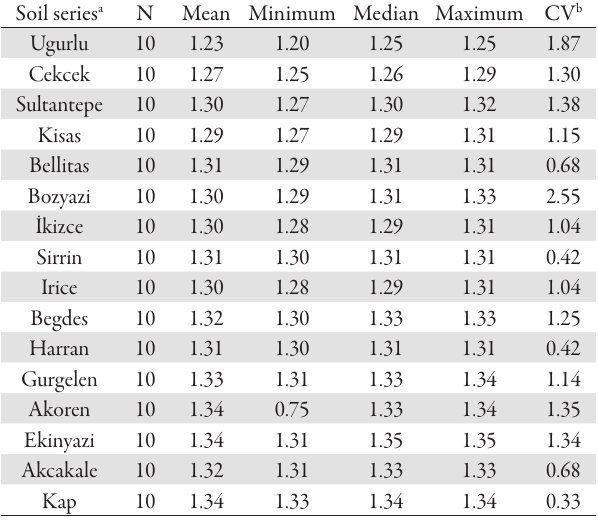
Tab. 3. Statistical distribution of bulk density (mg m -3